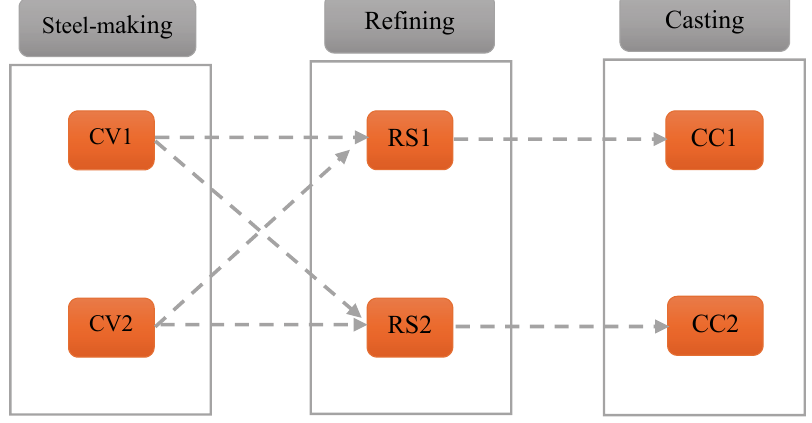
Fig. 1. Scheme of the